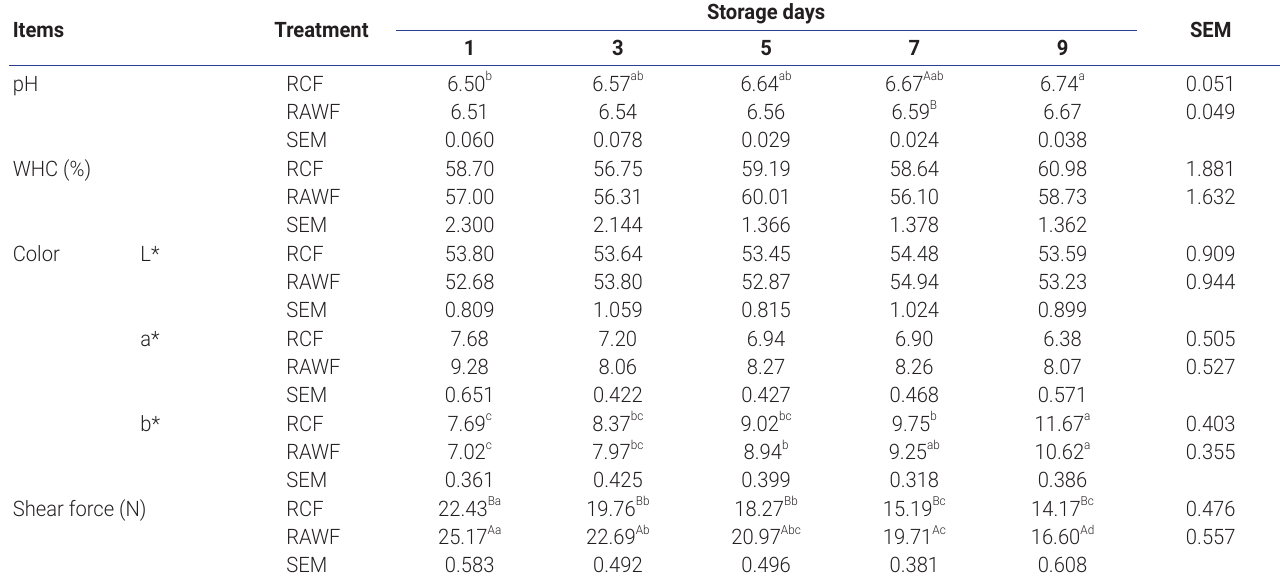
Table 3. Meat pH, water holding capacity (WHC), instrumental color, and shear force of thigh meat of Ross 308 broilers from conventional and animal welfare farming system during cold